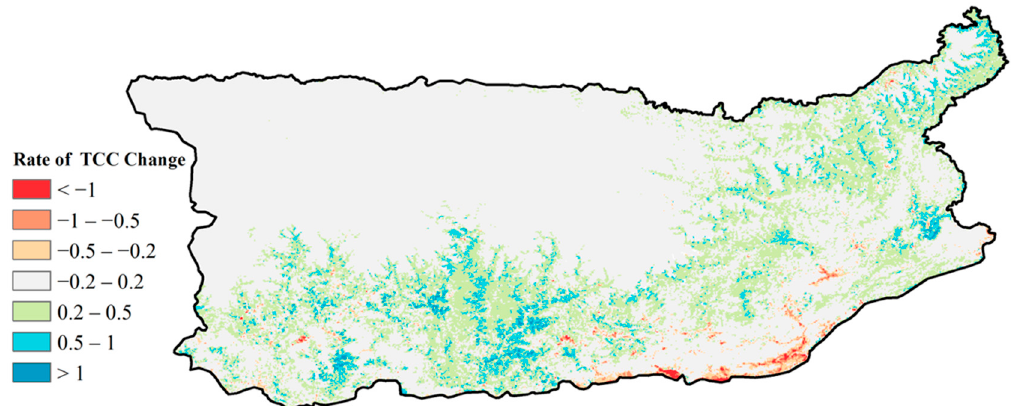
Figure 8. Spatial distribution of TCC change (%/year) from 1990 to 2020 in the Eastern Himalayas: Gains (green to blue) and losses (orange to red) of TCC.